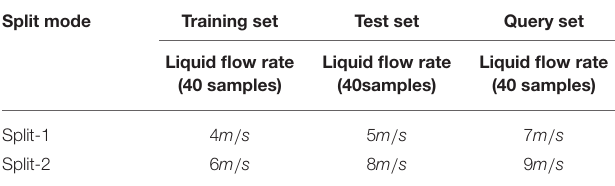
TABLE 3 | Partition of datasets. TABLE 4 | Comparison of prediction error and precision of models under different filling